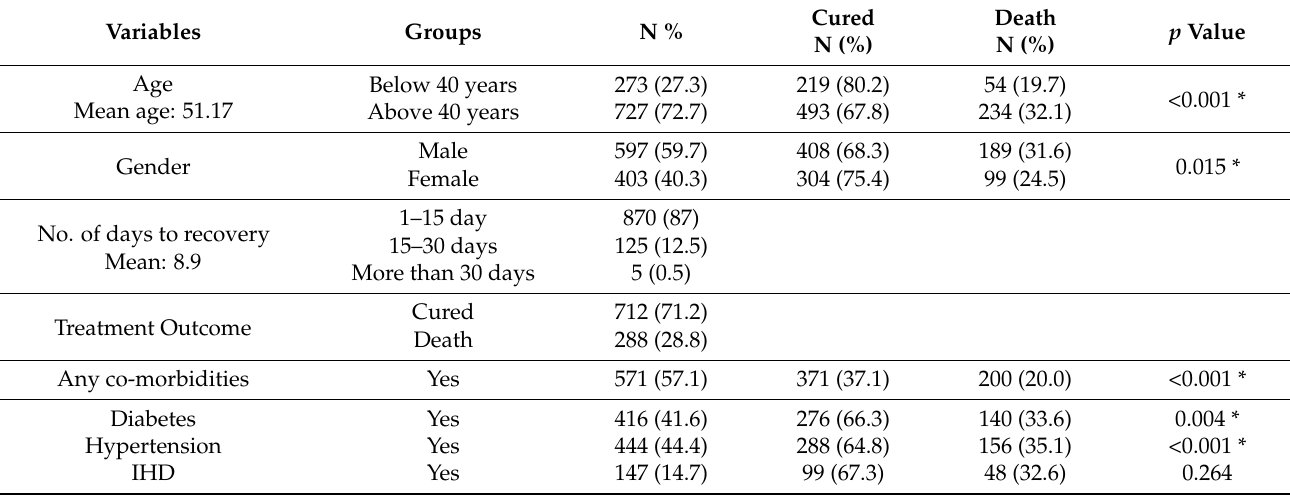
Table 1. Patient-related information with confirmed diagnosis of SARS-CoV-2 Infection (n = 1000).